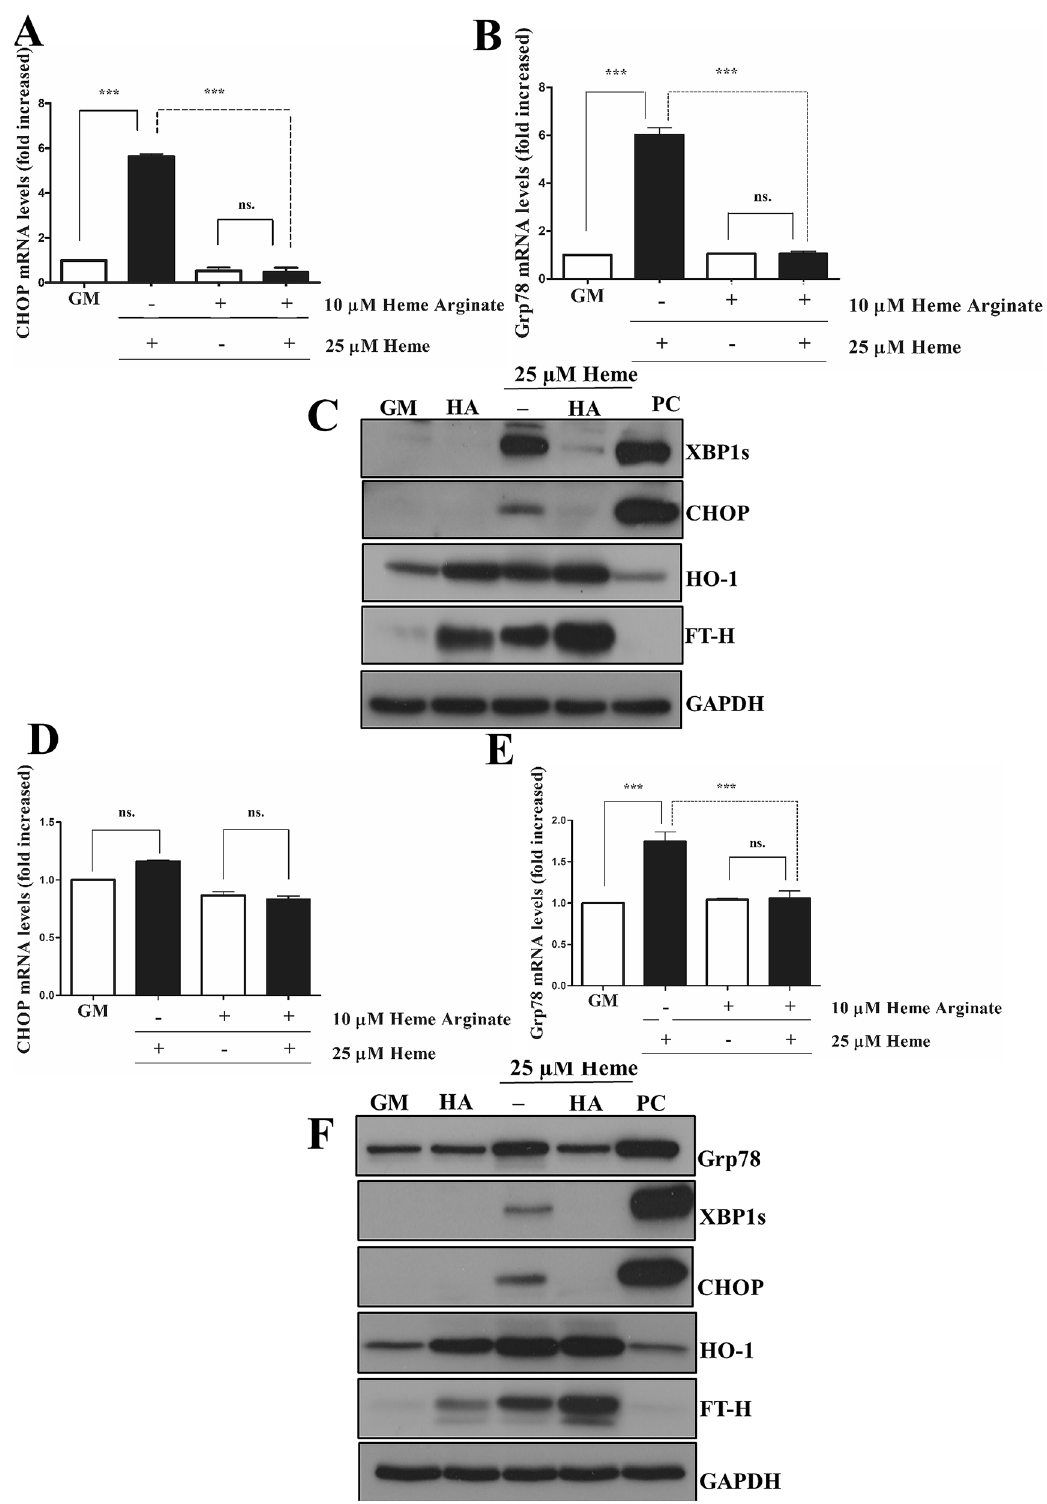
Figure 5. Heme arginate attenuates HIER stress in EC cultures. ECs were treated with 10 µM of HA in CM199 with 10% FCS and antibiotics overnight, then challenged with heme (25 µM) for 2 h in serum- and antibiotics-free CM199. Then, the medium was changed to CM199 with 10% FCS and antibiotics. Relative expression of ( A ) CHOP and ( B ) Grp78 mRNAs as well ( C ) spliced XBP1, CHOP, HO-1, and ferritin heavy chain protein levels were analyzed 3 h after the heme treatment. In another set of experiments, relative expression of ( D ) CHOP and ( E ) Grp78 mRNAs as well ( F ) Grp78, spliced XBP1, CHOP, HO-1, and ferritin heavy chain protein levels were analyzed 16 h after the heme treatment. GM growth medium, HA heme arginate, PC positive control. Relative mRNA expressions were normalized to GAPDH. GAPDH was used as a loading control in immunoblots. Immunoblots are cropped from different parts of the same gel. Uncropped immunoblots are presented in the Supplementary information. Data are shown as mean ± SEM of three independent experiments. Statistical analysis was performed by one-way ANOVA test followed by Bonferroni correction. A value of p < 0.05 was considered significant. *** p <